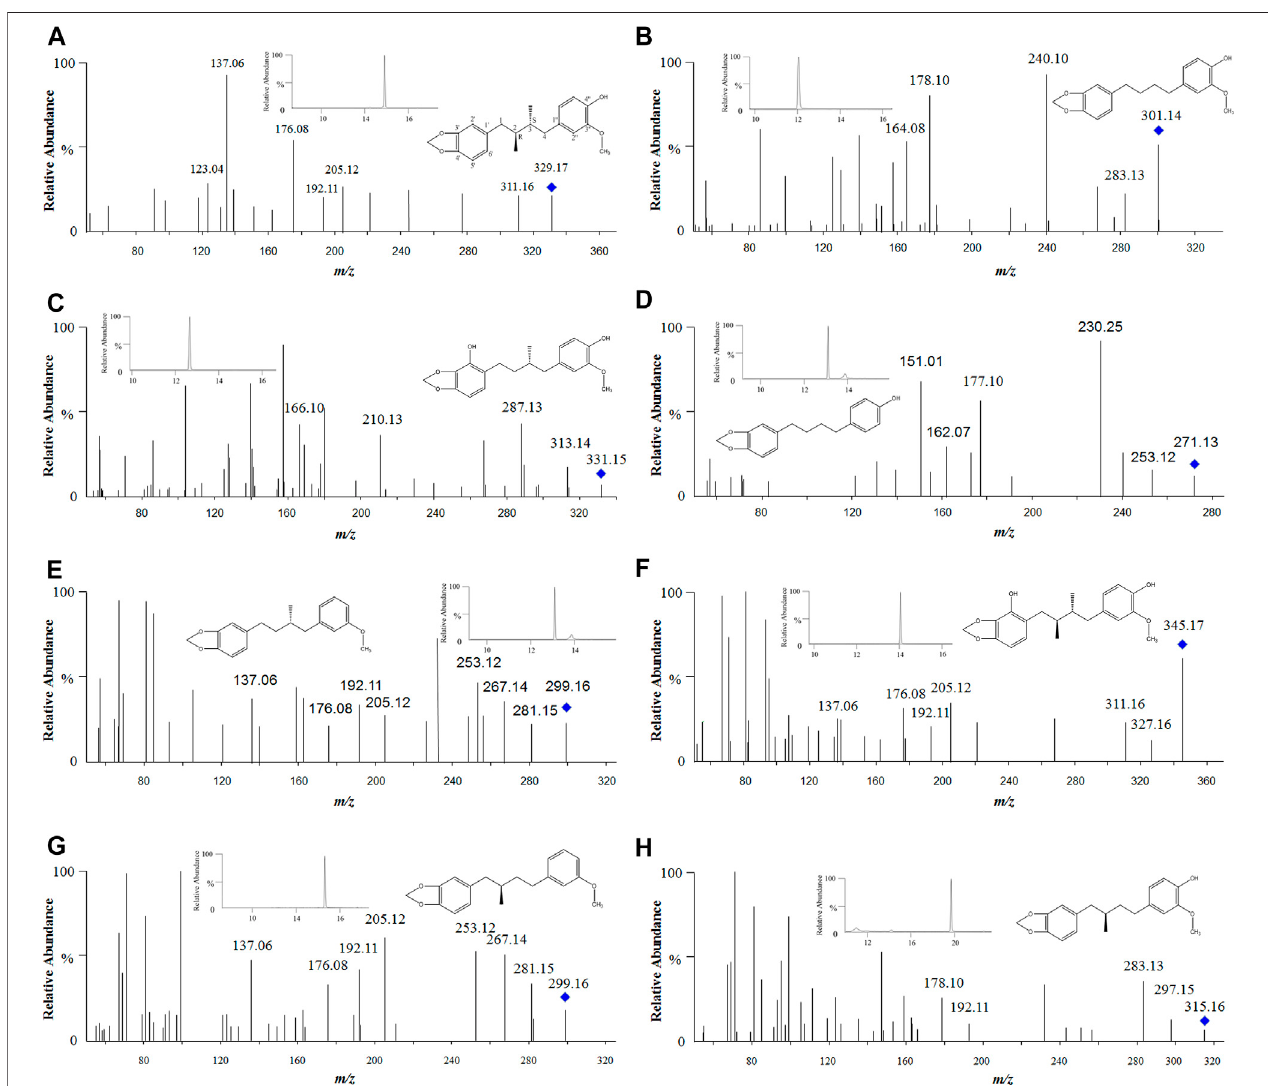
FIGURE 6 | Tandem mass spectra of anwulignan and its metabolites. Note: (A) anwulignan at m/z 329; (B) M1 at m/z 301; (C) M2 at m/z 331; (D) M3 at m/z 271; (E) M4 at m/z 299; (F) M5 at m/z 345; (G) M6 at m/z 299; and (H) M7 at m/z 315.